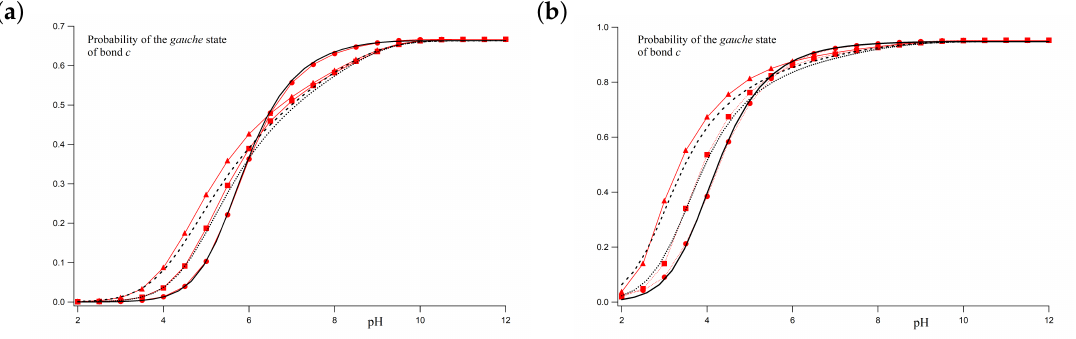
Figure 6. Gauche state probabilities of bond c versus the pH-value computed by means of MC simulations (red markers) and using the LEIP method (black lines) for ionic strengths: 1 M (circles and continuous line), 0.01 M (squares and dotted line) and 0.001 M (triangles and dashed lines). The chosen parameters are p K = 9, (cid:101) t = 1, u g = 0 and σ = 1 ( a ); σ = 10 ( b